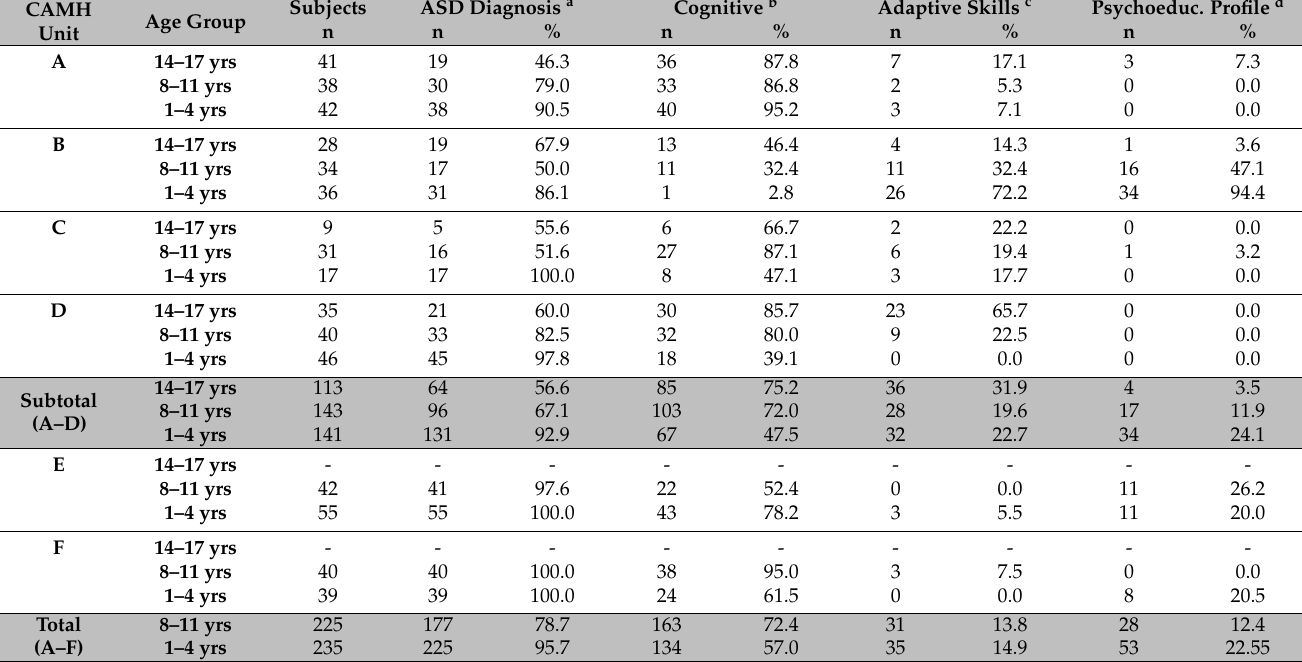
Table 7. Frequency of subjects assessed by the use of standardized tools for ASD diagnosis, cognitive function, adaptive skills and definition of psychoeducative profile by CAMH units and age